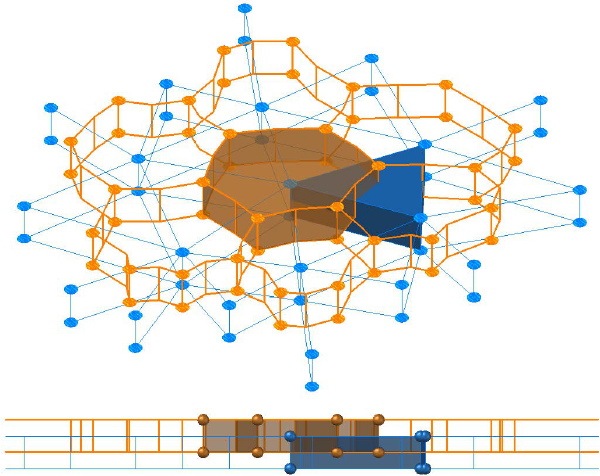
Figure 45: Staggering in 2D cell complexes with barycentric dual cells.